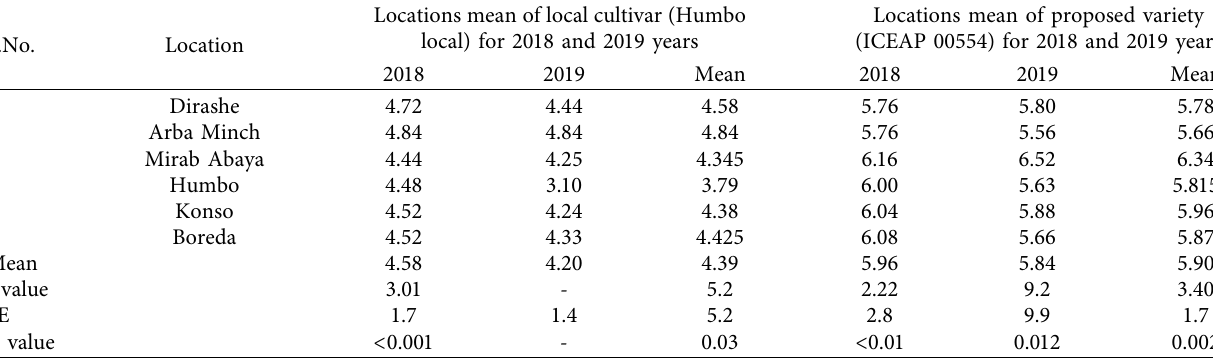
Table 3: Number of seeds per pod of pigeon pea genotypes across locations during 2018 and 2019 cropping seasons, South Ethiopia. S.No.